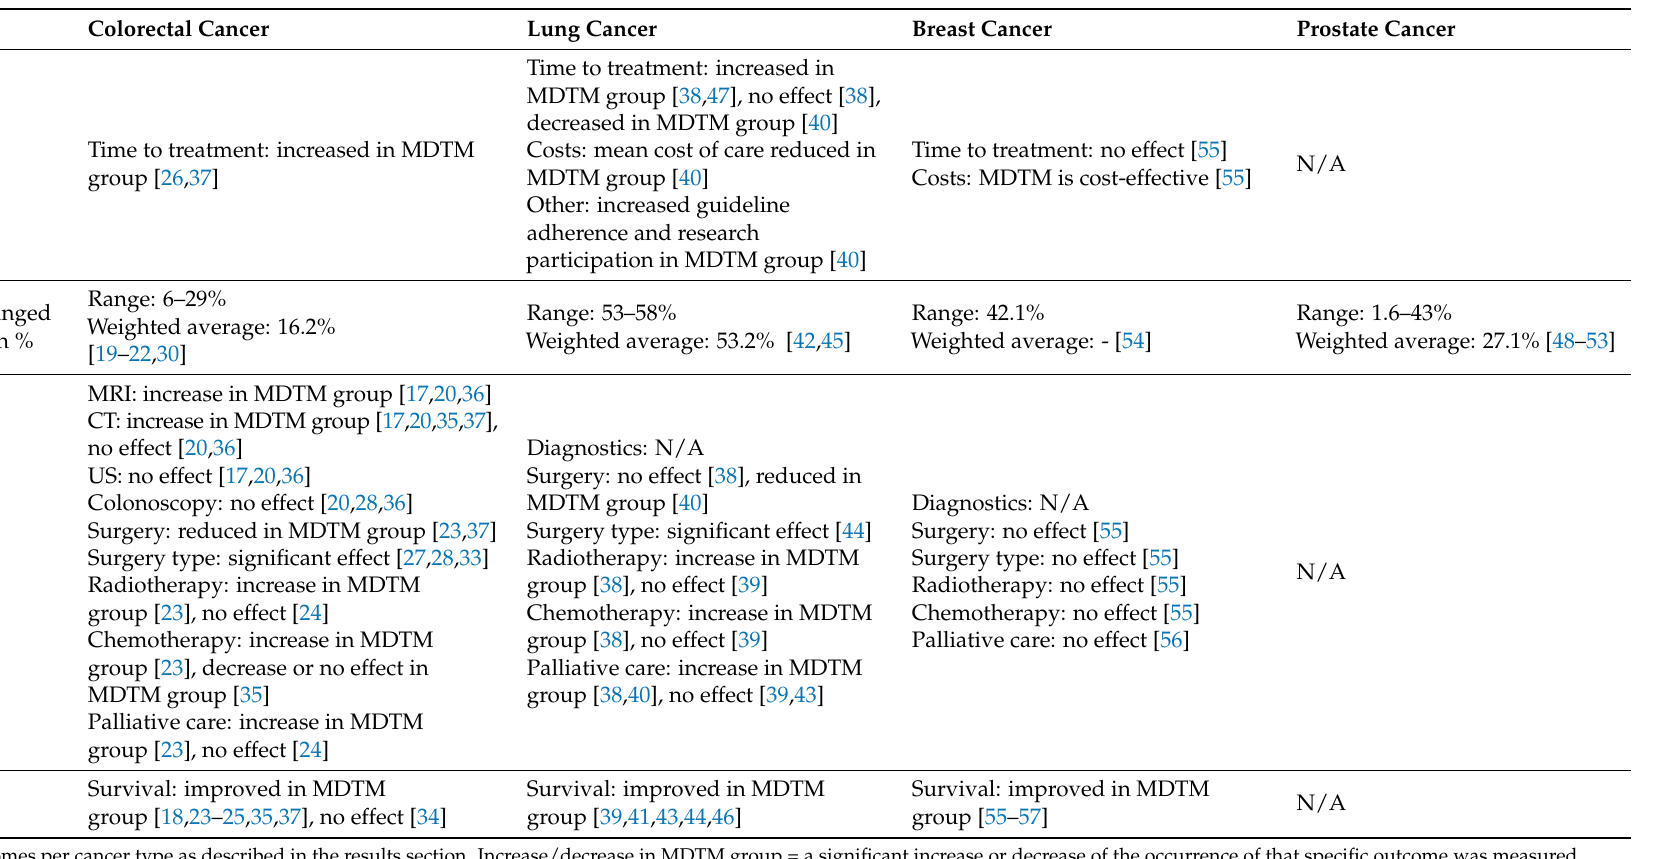
Table 6. Summary of main outcomes per cancer